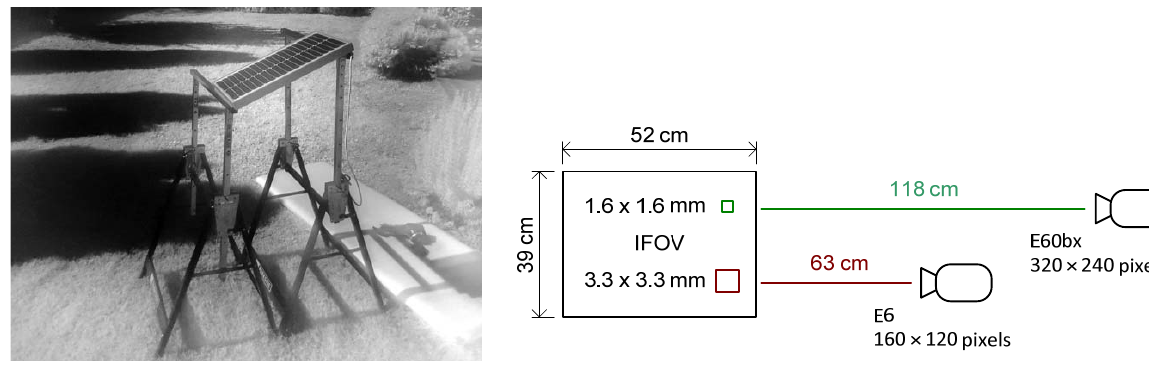
Figure 7. Photograph of the pilot setup, taken at 720 nm. The expected values of the temperature difference, according to the literature [11], were in the range of 10 ◦ C. Figure 8 shows the temperature distribution on the module, recorded by the FLIR E60bx